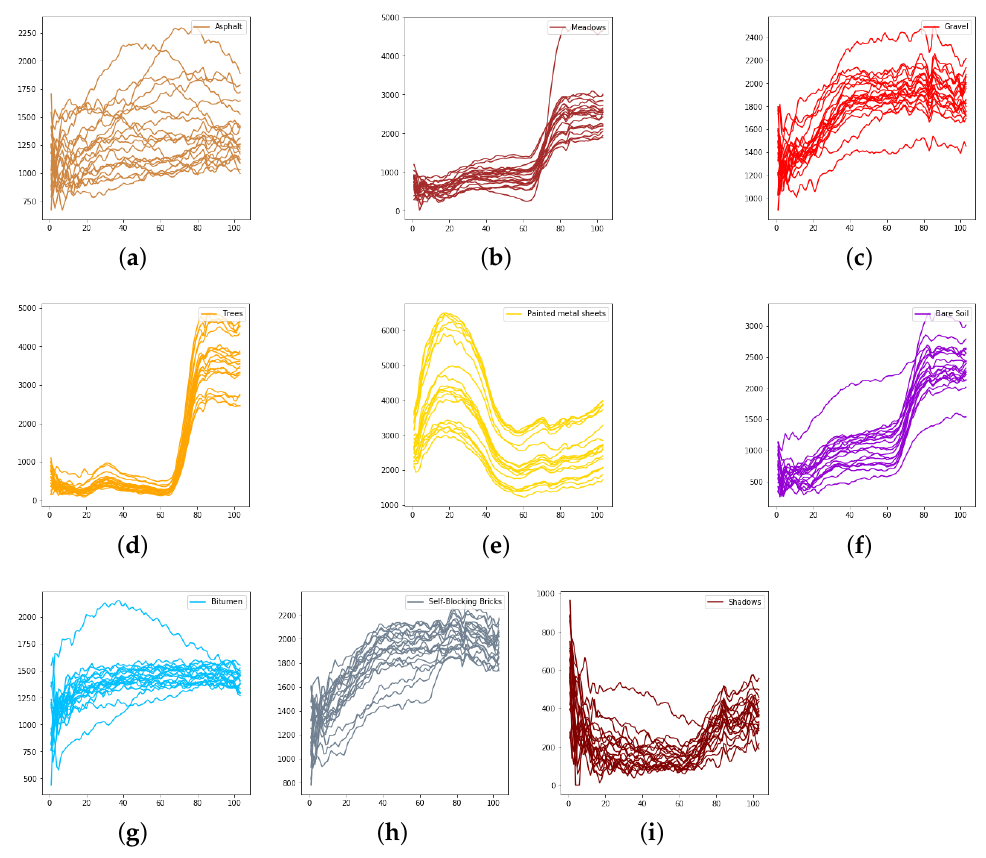
Figure 11. The spectral radiance of different pixels and the corresponding categories in the University of Pavia. ( a ) Asphalt. ( b ) Meadows. ( c ) Gravel. ( d ) Trees. ( e ) Painted metal sheets. ( f ) Bare Soil. ( g ) Bitumen. ( h ) Self-Blocking Bricks. ( i )